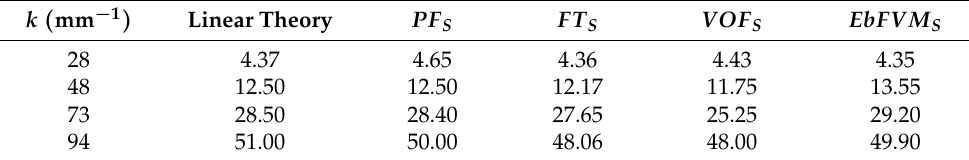
Table 2. Comparison of critical amplitude values a c / g in the linear regime.